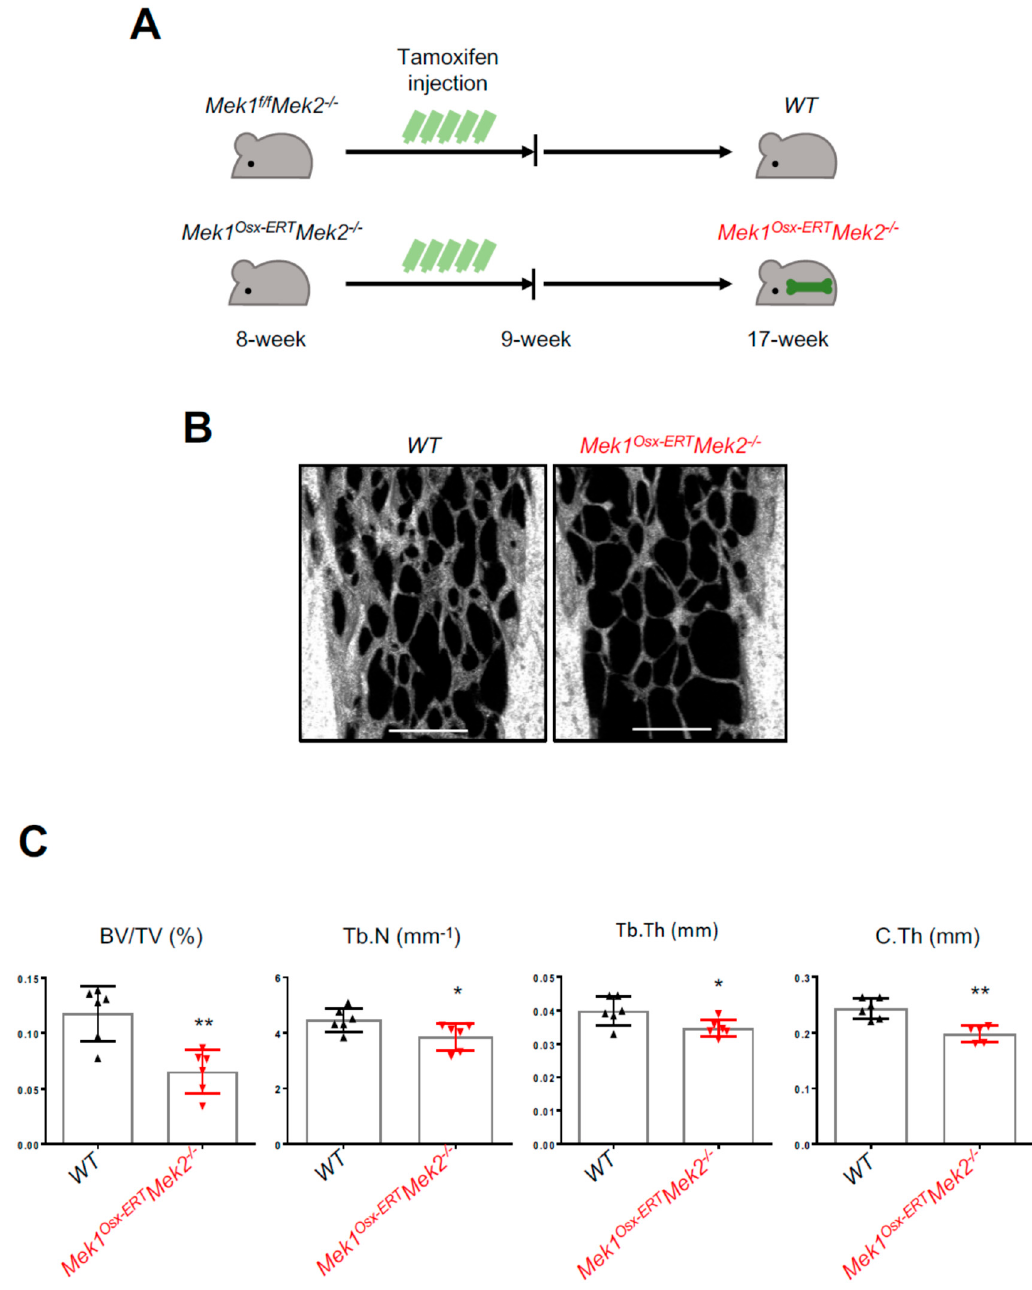
Figure 4. Inducible inactivation of ERK in osteoprogenitors decreases bone mass in adult mice. ( A ) A diagram of the strategy for tamoxifen ‐ induced deletion of Mek1 and Mek2 in osteoprogenitors. ( B,C ) MicroCT analysis of 17 ‐ week ‐ old male WT and Mek1 Osx ‐ ERT Mek2 − / − femurs. 3D ‐ reconstruction images (B) and quantification (C) are displayed. Trabecular bone volume / total volume (BV / TV), trabecular thickness (Tb.Th), trabecular number per cubic millimeter (Tb.N), and cortical thickness (C.Th). ( n = 5~6). Scale bar, 500 µ m. Values represent mean ± SD.; * p < 0.05 and ** p < 0.01 by an unpaired two-tailed Student’s t -test